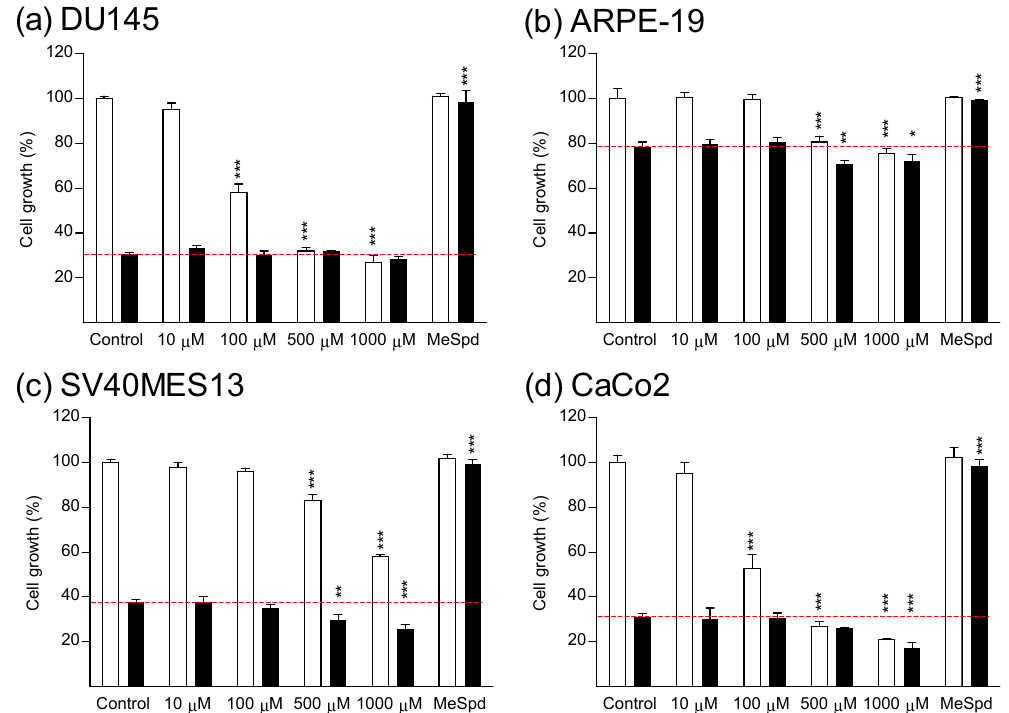
Figure 2. Effect of thymidine and ( S )-1-MeSpd on the growth of various cell lines. ( a ) DU145, ( b ) ARPE-19, ( c ) SV40MES13 and ( d ) CaCo2 cells. The cells were treated with 10–1000 µ M thymidine or ( S )-1-MeSpd (100 µ M) in the presence (black bars) or absence (white bars) of DFMO (5 mM) for 7 days (DU145 cells) or 4 days (other cell lines). Data are means ± SD, n = 6. *, **, and *** refer to statistical significance of p < 0.05, p < 0.01 and p < 0.001 as compared to control/DFMO groups, respectively. The red dotted line indicates the level of cell growth of DFMO-treated cells.